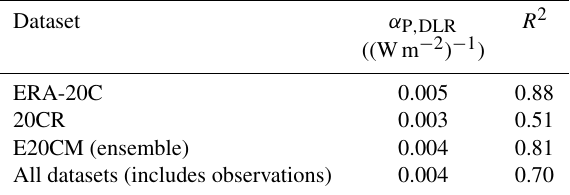
Table 2. Linear regression coefficient α P , DLR estimated from (cid:49)P/P c against (cid:49) DLR at 2-year resolution, assuming a relationship as given by Eq. (11). The respective coefficients of determination are also provided. The α P , DLR values are computed for ERA-20C, 20CR, and for the ensemble of ERA-20CM simulations. Addition- ally, the coefficient is estimated by pooling together all datasets, including GPCP observations against DLR from